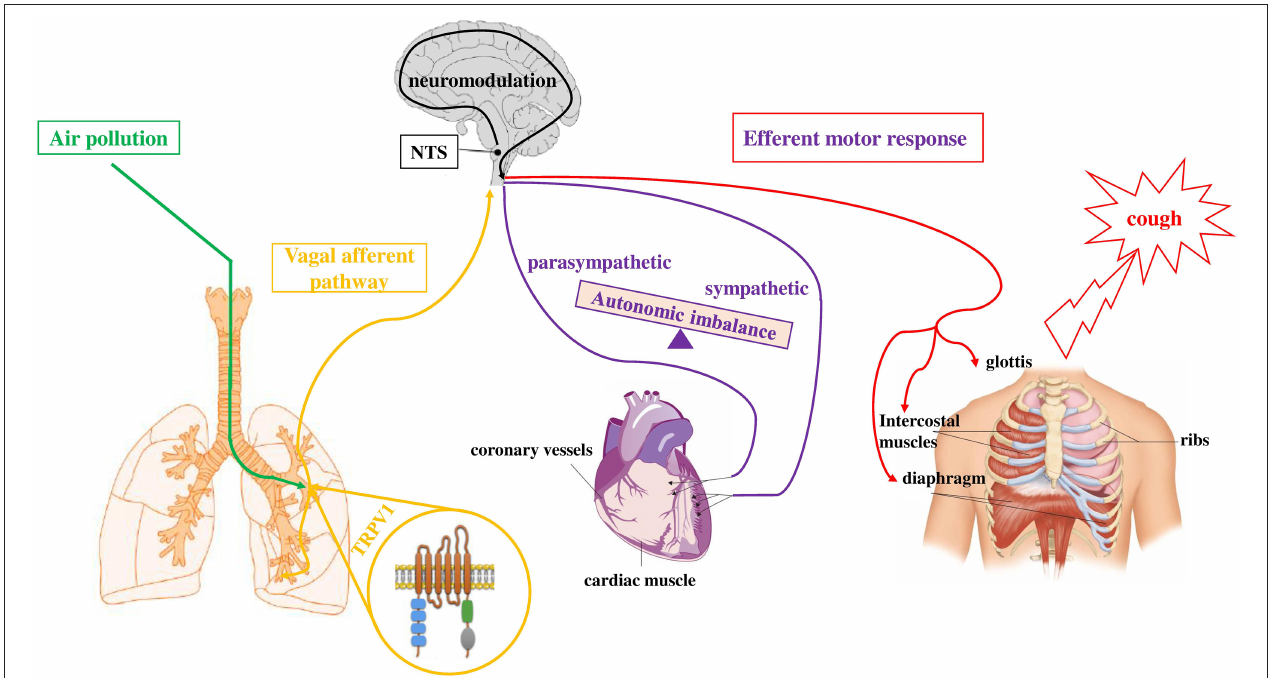
FIGURE 2 | Simplified depiction of how exposure to air pollutants is proposed to sensitize the sensory to autonomic reflex arc and alter subsequent responses. Inhaled component of air pollution (i.e., DEP), directly sensitizes TRPV-1 (green pathway) located on vagal bronchopulmonary C-fibers endings. Activation of airways sensory nerves (yellow pathway) stimulates neurons in the midbrain (NTS) and, through a neuromodulation process in the CNS, causes the efferent motor responses (red and violet pathways) to the heart (autonomic imbalance) and to respiratory muscles (cough). Adapted from